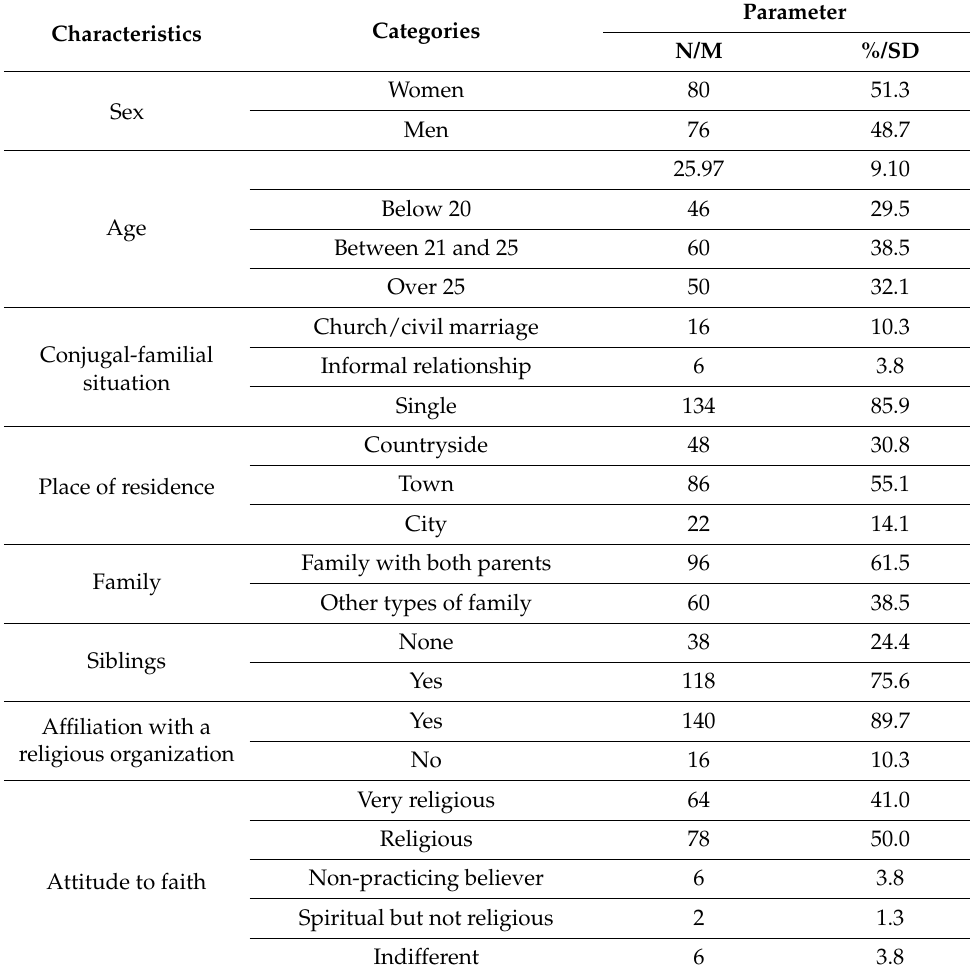
Table 2. Characteristics of the study